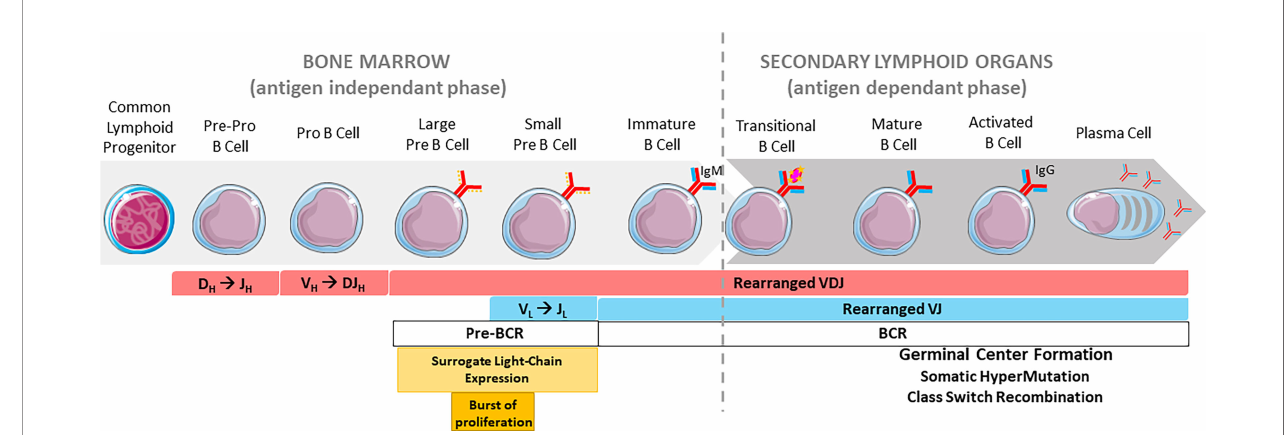
FIGURE 1 | Overview of B cell development. Chronological order of B cell stages in the bone marrow (left) and secondary lymphoid organs (right). The pre-BCR is represented by a continuous red line and a discontinuous orange line (surrogate light chain). The BCR is represented by continuous red and blue